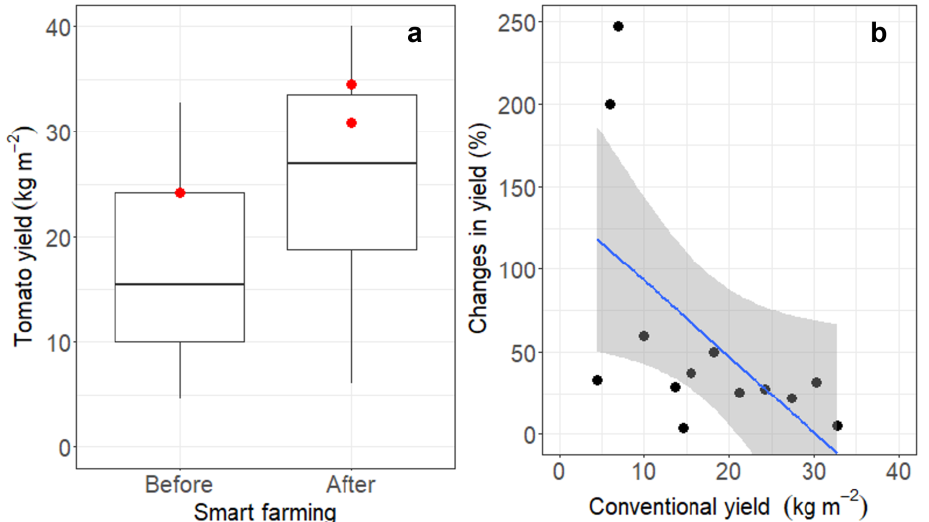
Figure 4. Boxplots of the measured tomato yields ( a ) and a scatter plot with linear regression to show farm-level changes in yield (%) after smart farming ( b ) from conventional yields. The red circles show the yields for a smart farm that implemented leaf temperature sensing.